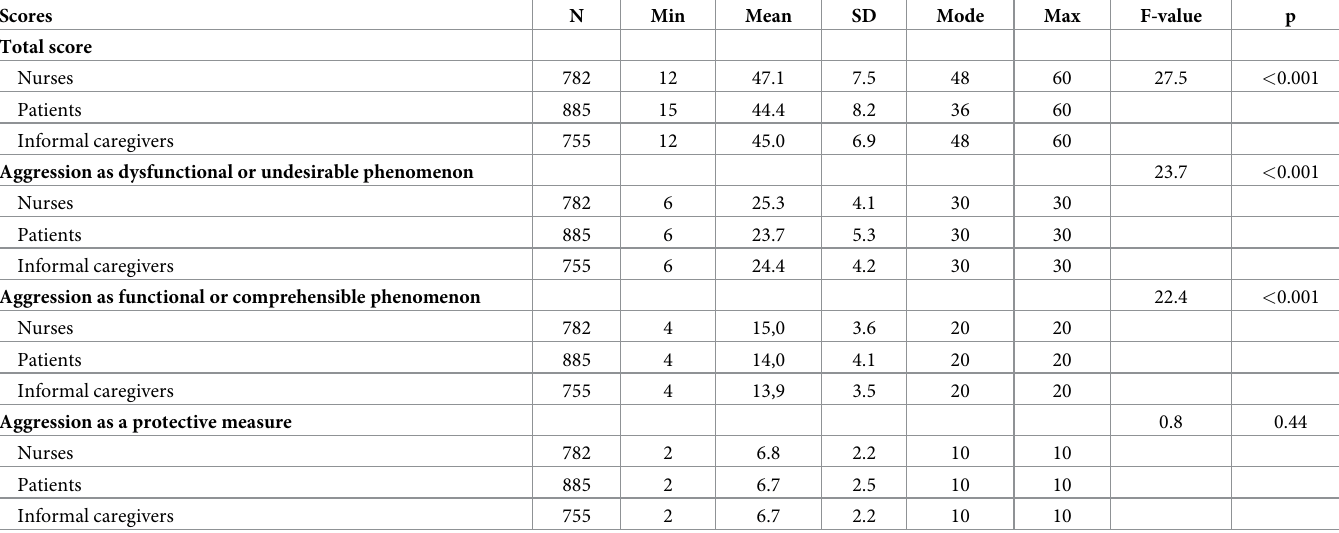
Table 3. Differences between POAS-S total scores and sub-scores in nurses’, patients’, and informal caregivers’